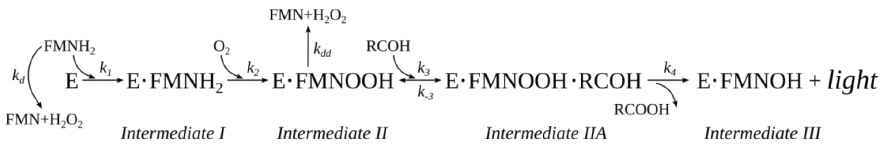
Figure 1. The stages of the reaction, catalyzed by bacterial luciferase. E—enzyme, FMN—flavin mononucleotide, O 2 —molecular oxygen, RCOH and RCOOH—long-chain aldehyde and correspond- ing carbonic acid, H 2 O 2 —oxygen